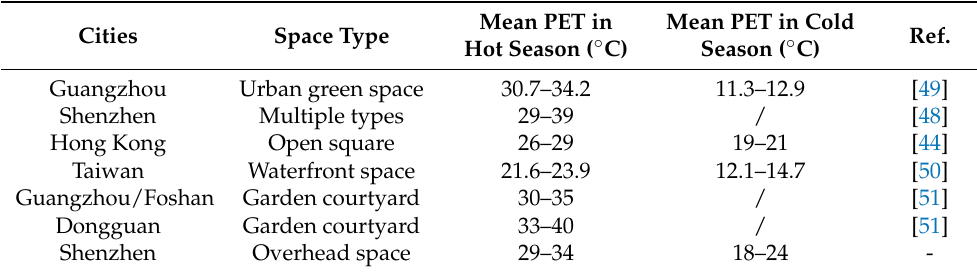
Table 14. Mean hot season and cold season PET for different spaces in hot summer and warm winter regions.